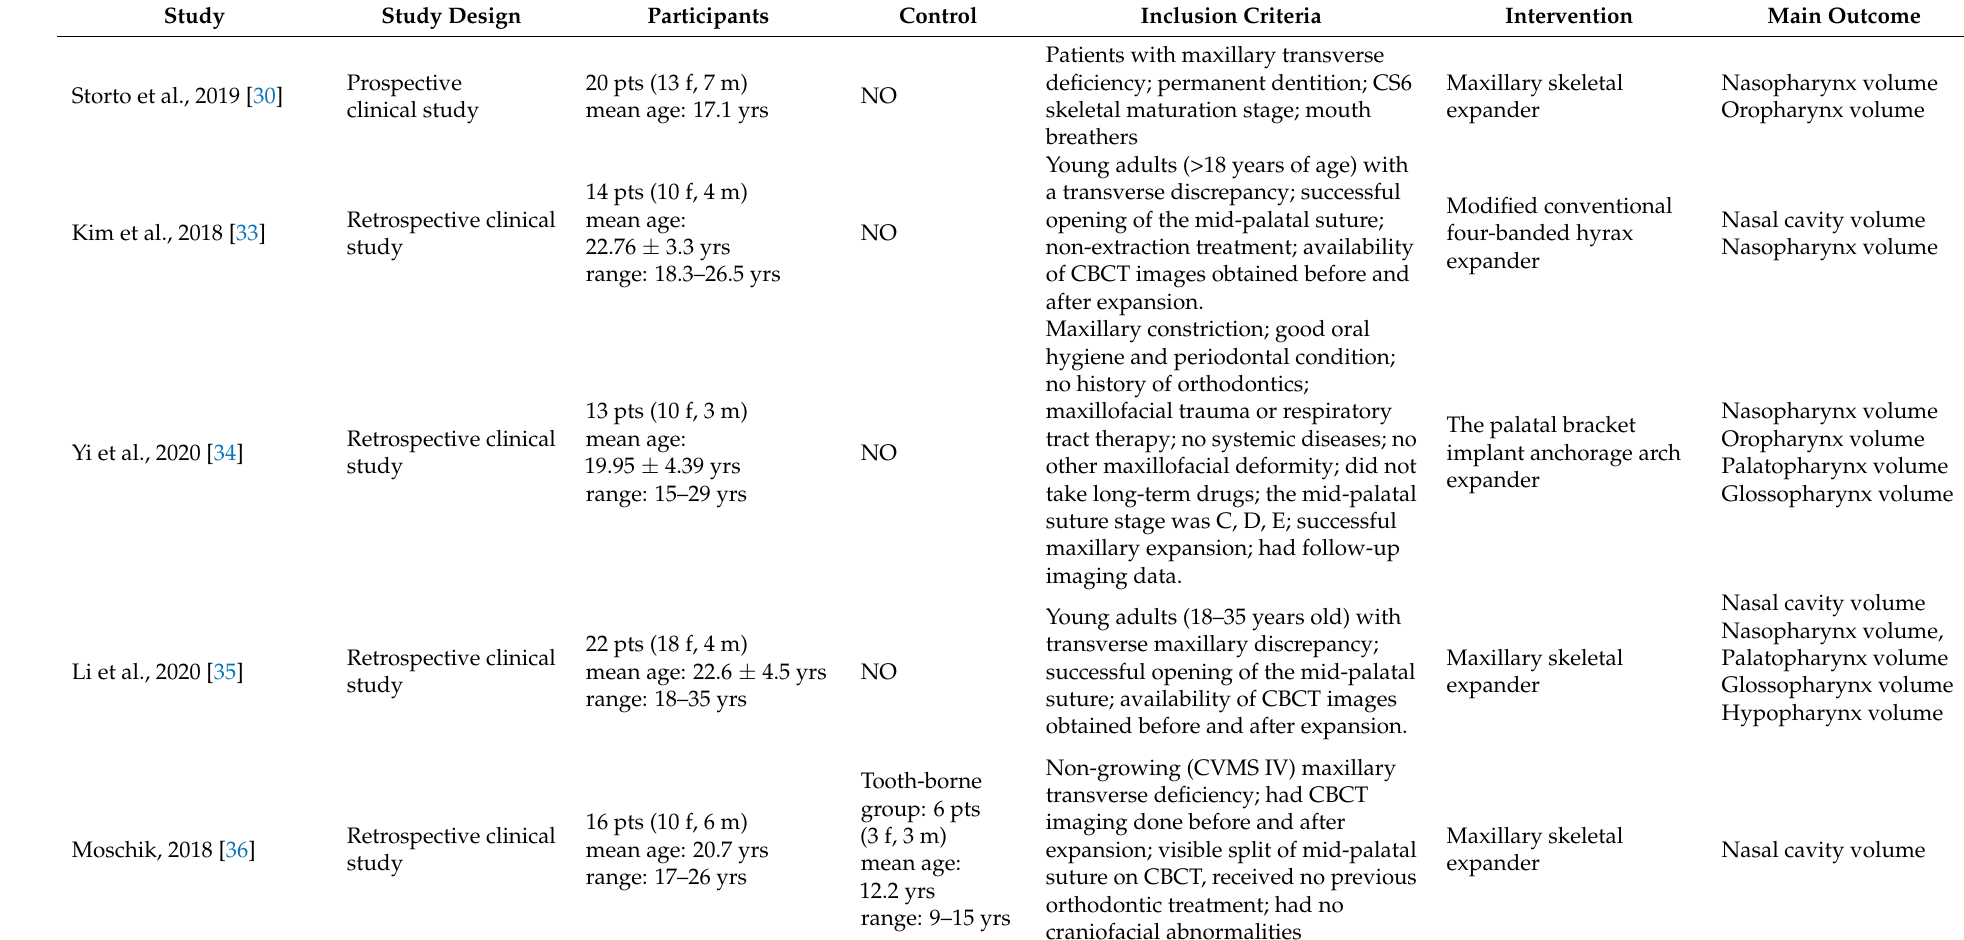
Table 1. Main characteristics of the included studies in this systematic